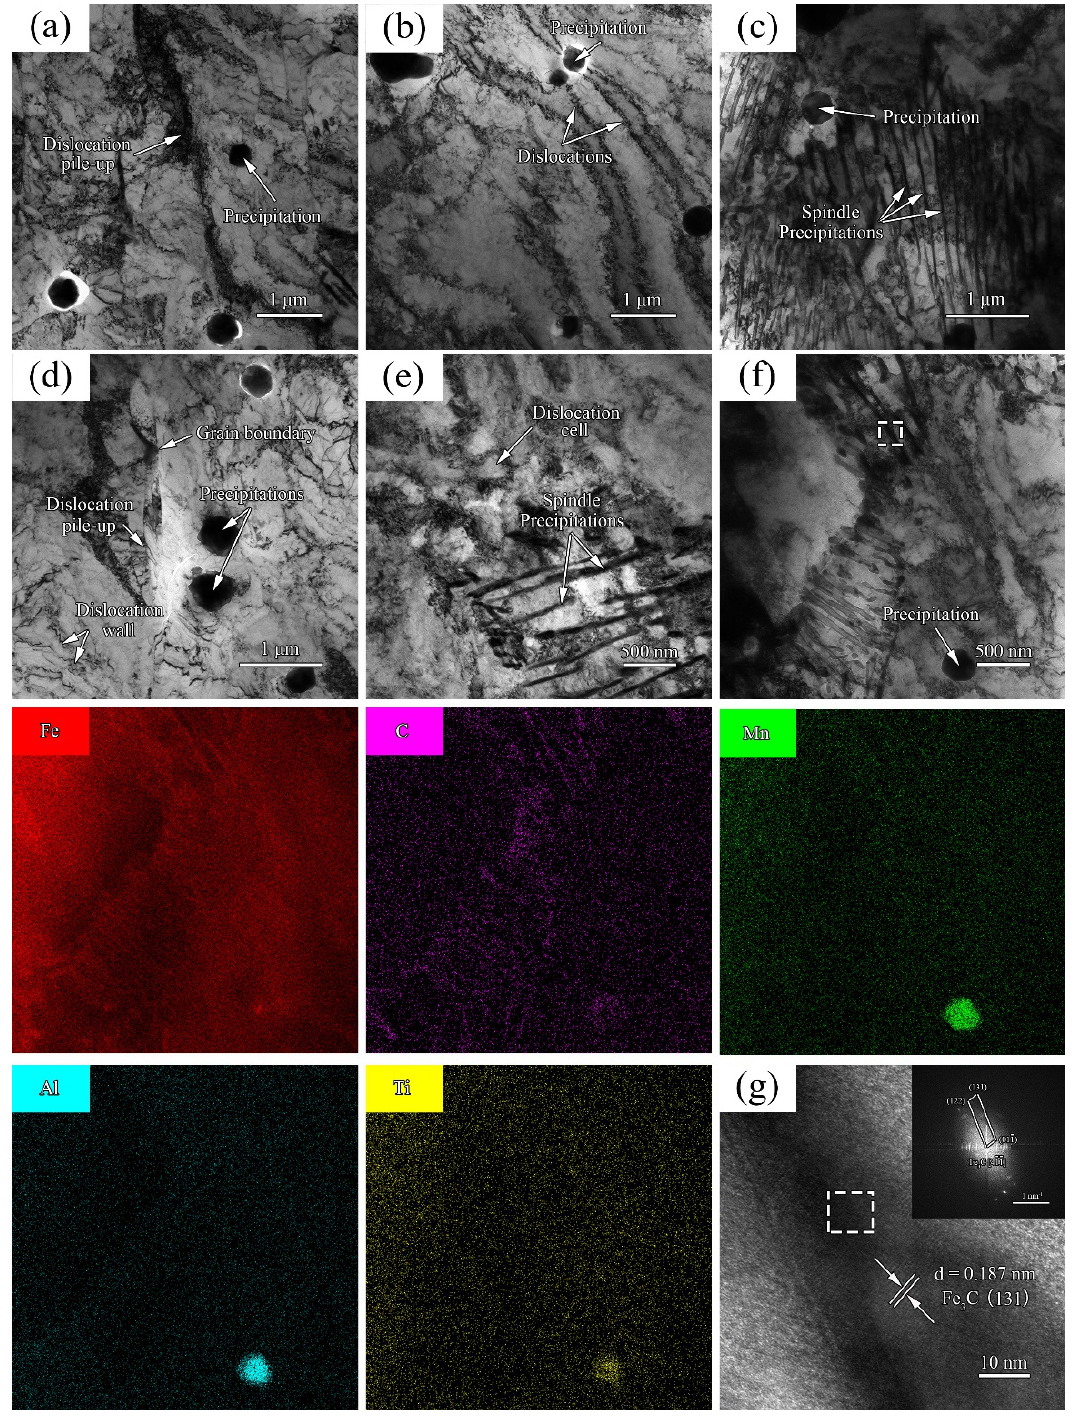
Figure 15. Morphology of precipitations and dislocations in the CPF zone of LSM-CPF process for 4000 W treatment: ( a ) dislocation pile-up of sample 5; ( b ) dislocation tangle of sample 5; ( c ) precipitations of sample 5; ( d ) dislocation pile-up of sample 6; ( e ) dislocation cell of sample 6; ( f ) precipitations and elements distribution of sample 6; and ( g ) HRTEM of image of the white square marked zone and corresponding FFT pattern.